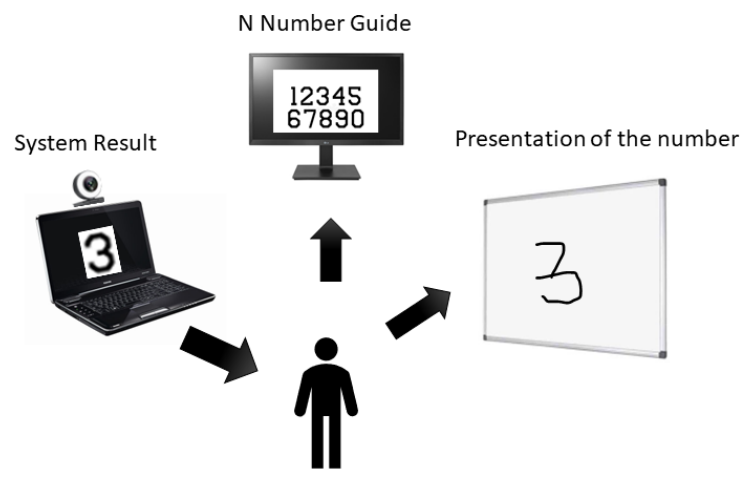
Figure 1. Natural number recognition system architecture and its components.